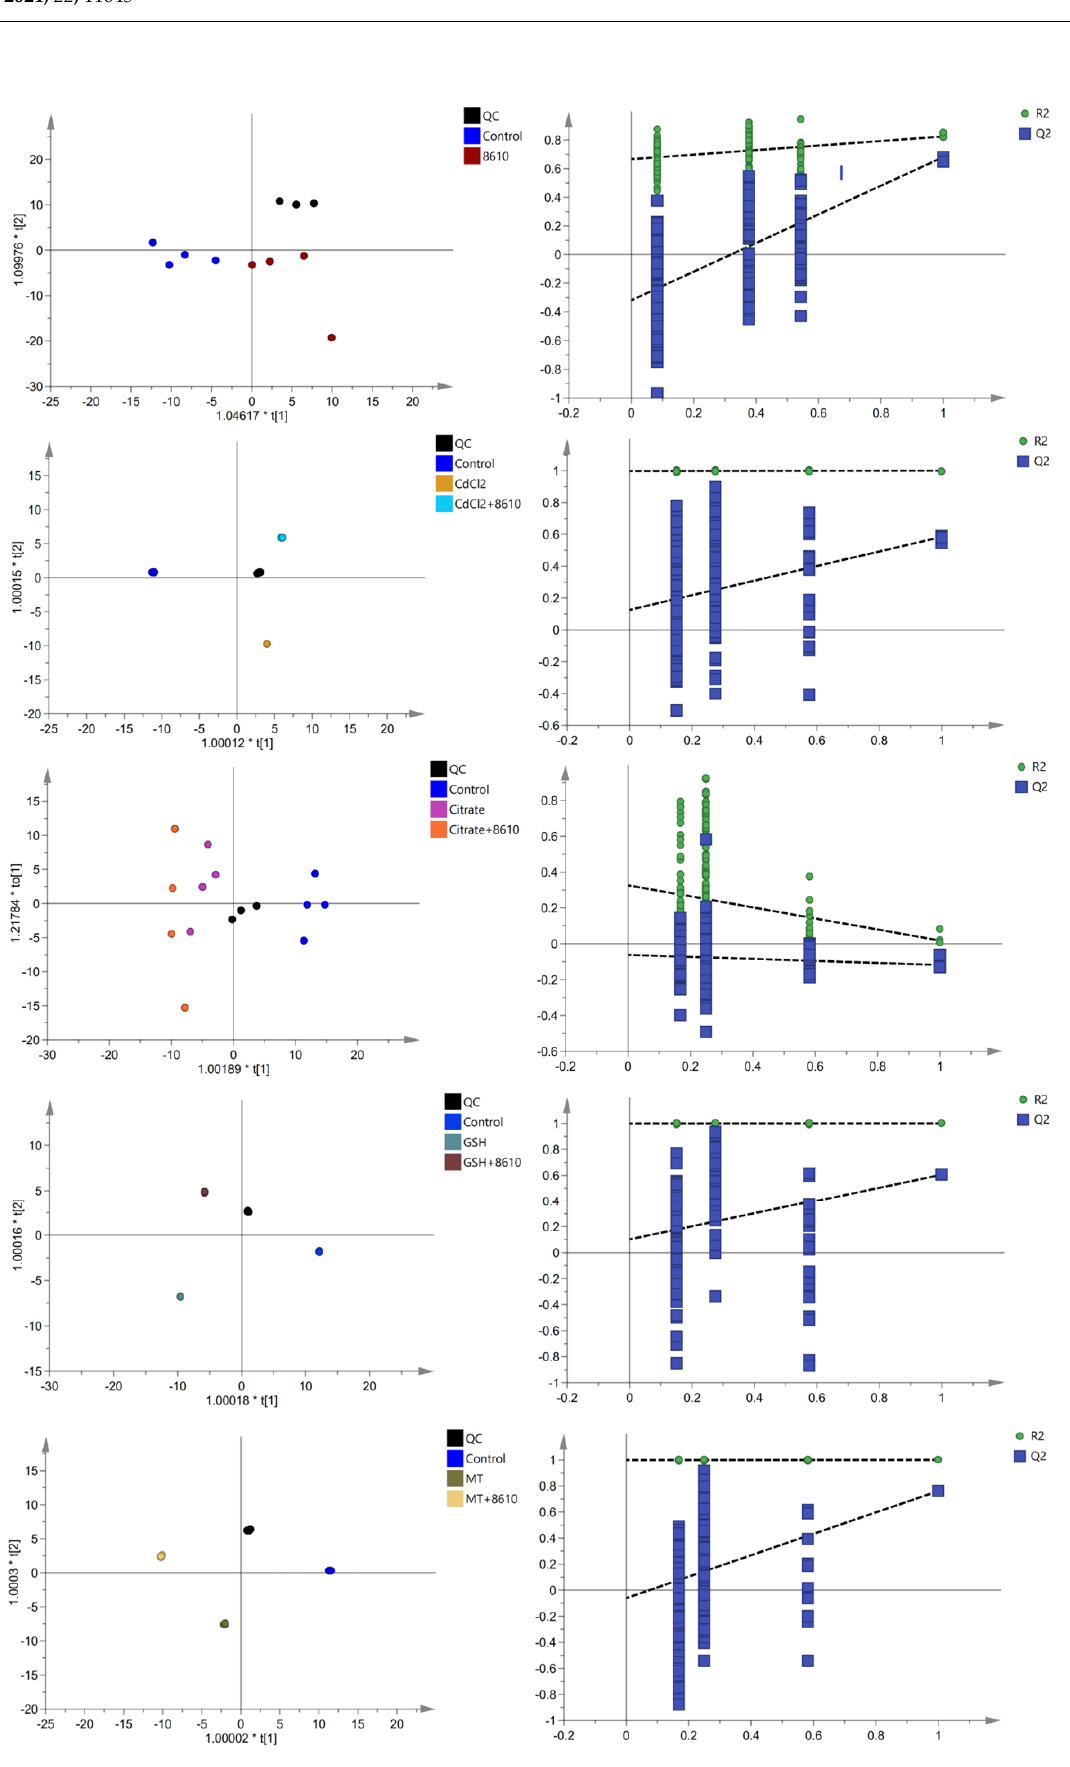
Figure 5. A plot of OPLS–DA scores of the different groups based on their metabolites.